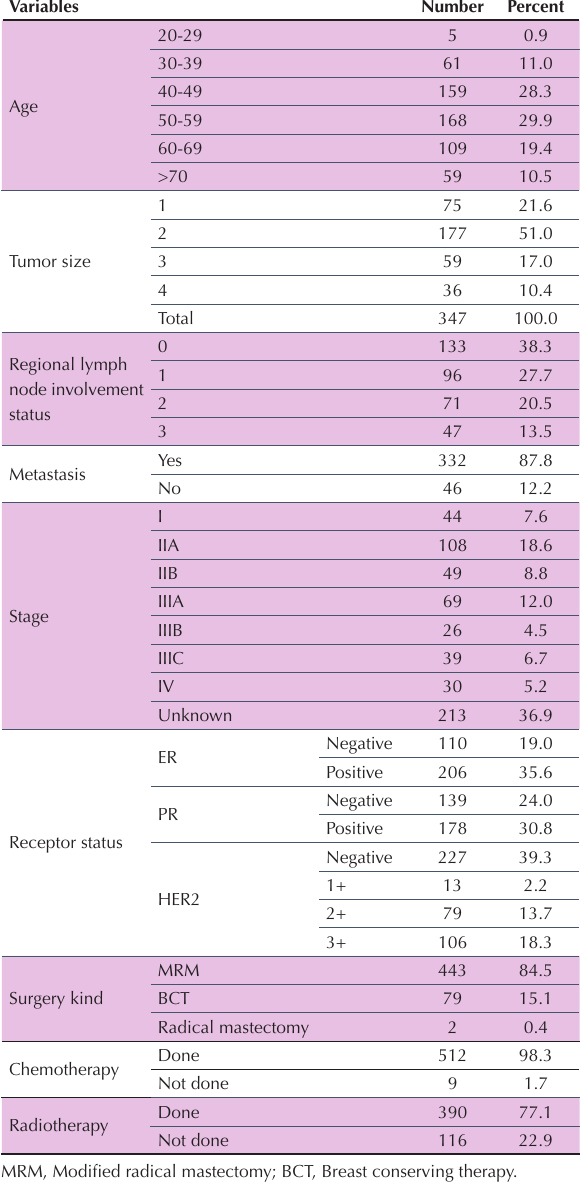
Table 1. Clinical and treatment characteristics in breast cancer patients